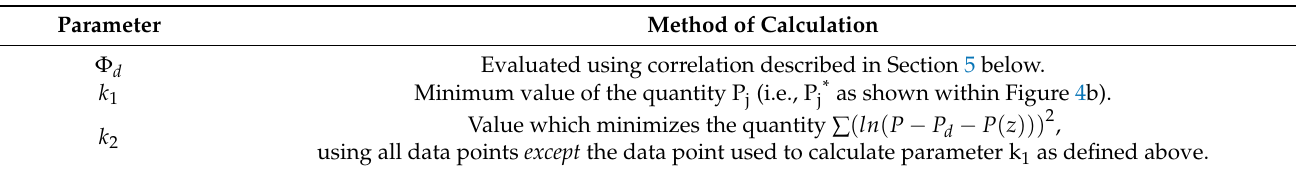
Table 1. Derivation of the Φ d , k 1 and k 2 parameters within Equation (7). Method of